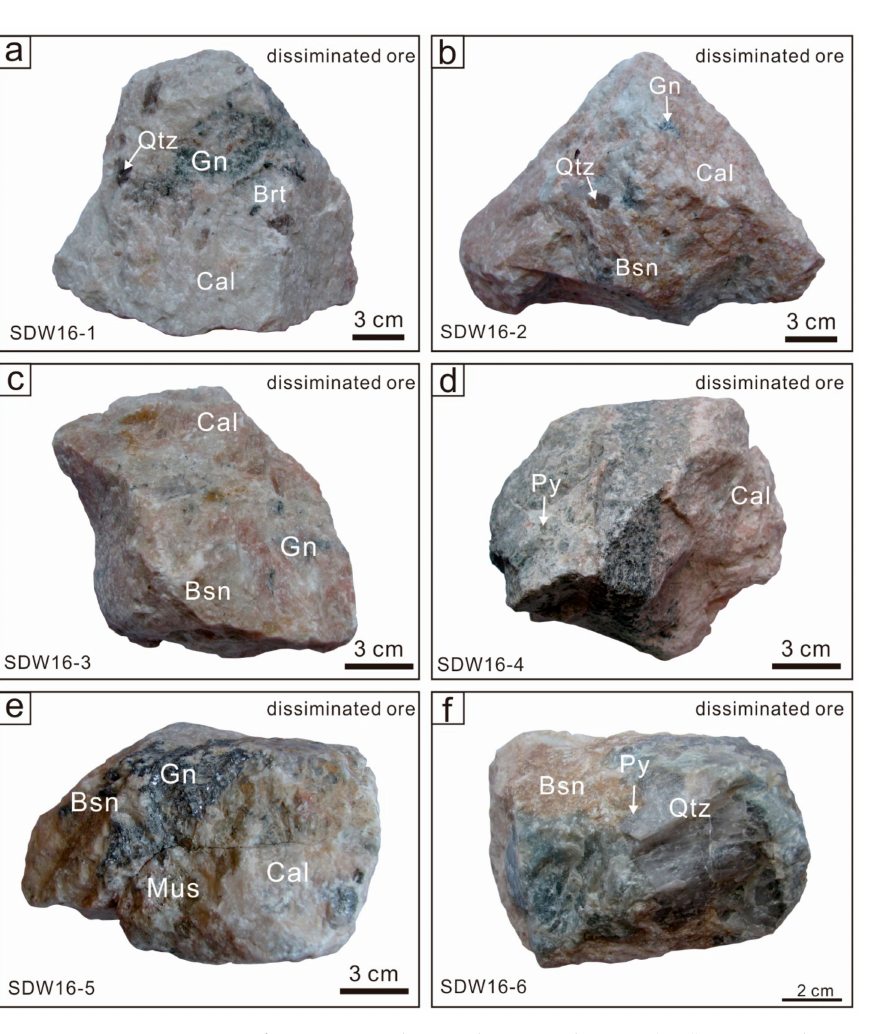
Figure 4. Representative images of ore types in the Weishan REE deposit. ( a – d ) Massive disseminated ore containing calcite, quartz, barite, galena, and bastnäsite. ( b , c , e ) Pale red ore containing red calcite, galena, and bastnäsite. ( f ) Massive ore containing calcite, bastnäsite, and quartz. Bsn = bastnäsite; Cal = calcite; Gn = galena; Mus = muscovite; Py = pyrite; Qtz =